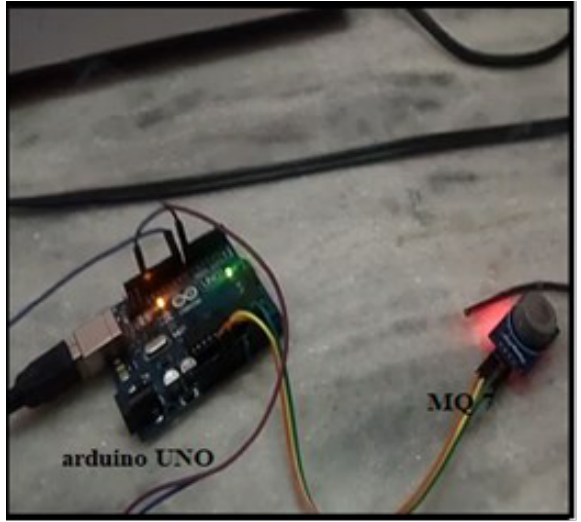
Figure 4. Intelligent fire detector prototype